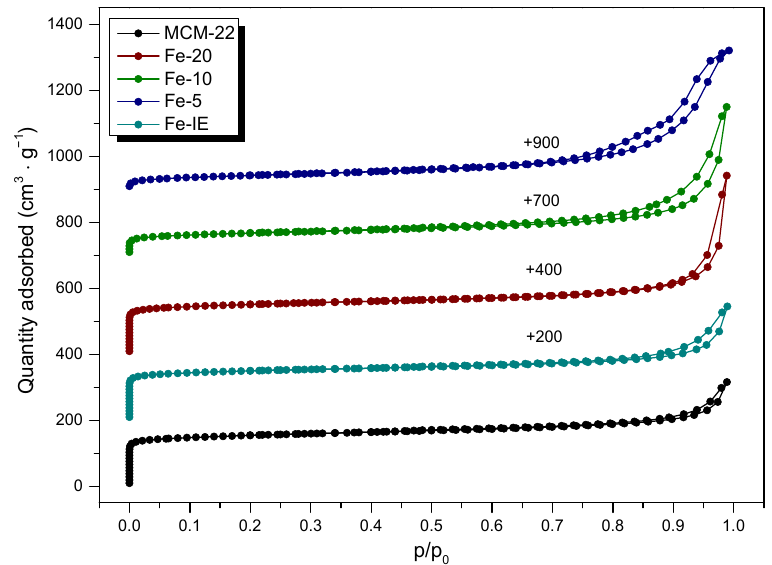
Figure 5. Nitrogen adsorption-desorption isotherms obtained for non-modified MCM-22 and the catalysts (for better visibility, the isotherms were shifted by the values given in the figure).